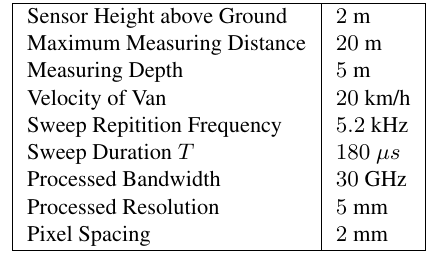
Table 2: Parameter for SAR processing and mapping